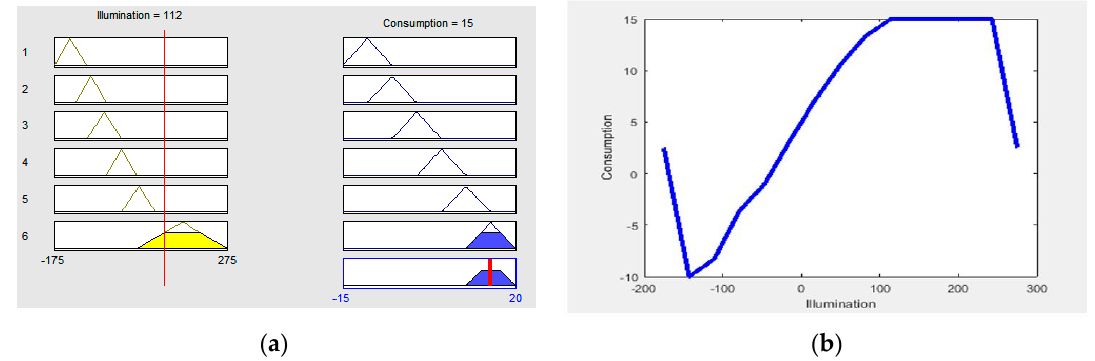
Figure 10. ( a ) Applied rule for a single value based on the illumination fuzzy controller. ( b ) The power